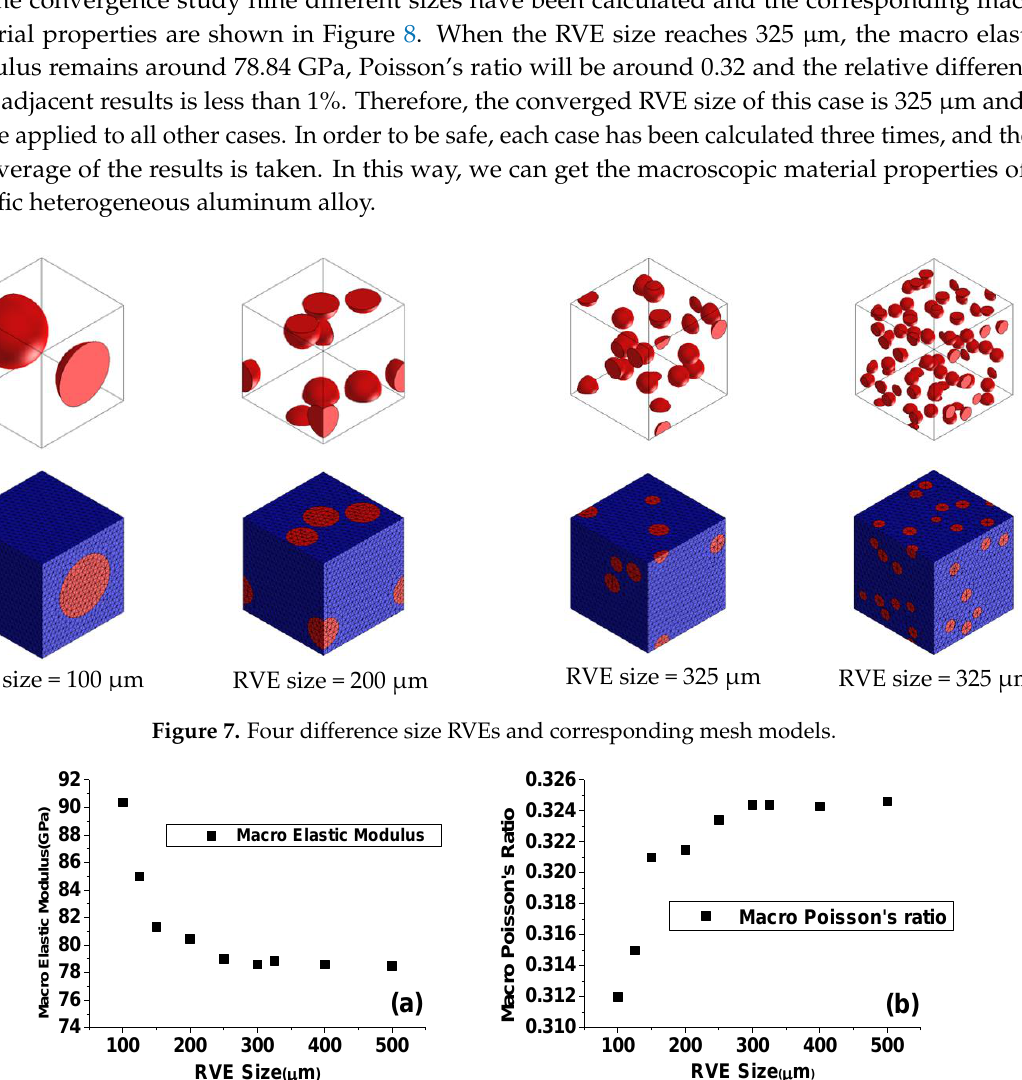
Figure 8. Convergence of ( a ) macro elastic modulus and ( b ) Poisson’s ratio.